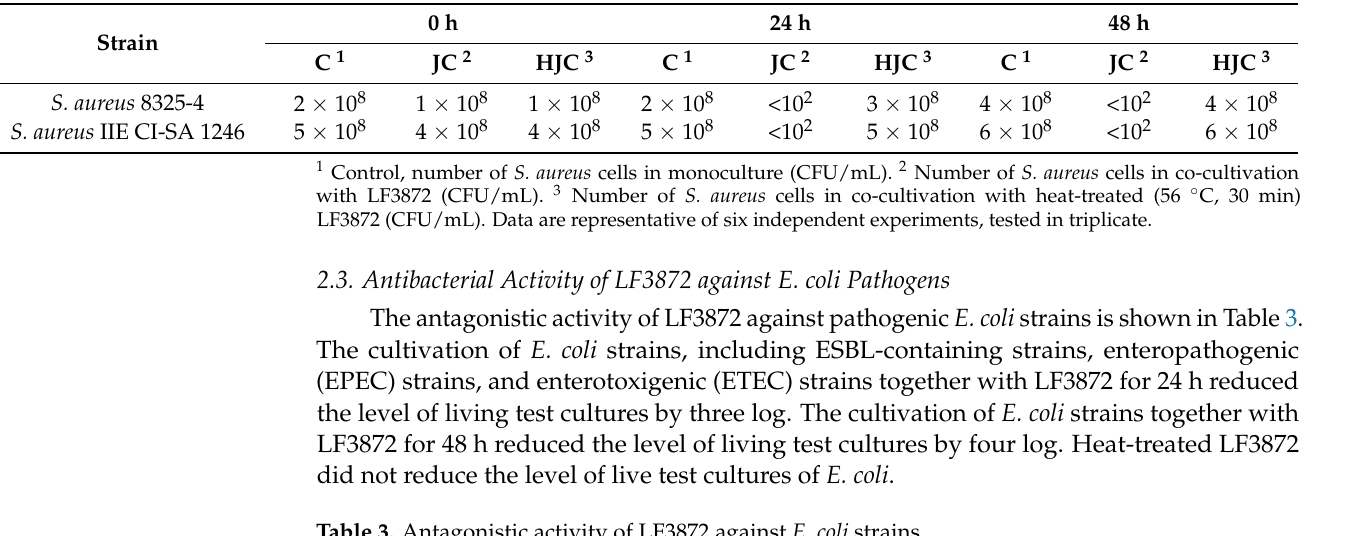
Table 3. Antagonistic activity of LF3872 against E. coli